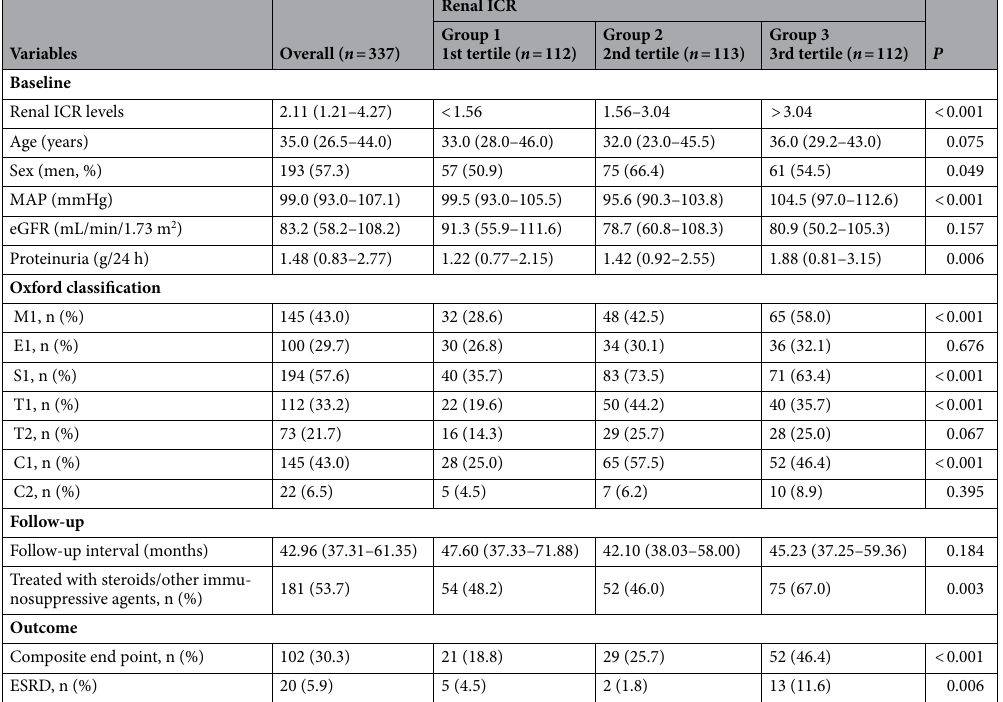
Table 1. Characteristics of IgA nephropathy patients by renal ICR tertiles at biopsy. Values were presented as number (percent) or median (25th percentile-75th percentile). Kruskal–Wallis test or chi-square test was used to compare the values among groups. The last column represents the P -values from comparisons between group 1, 2 and 3. MAP mean arterial pressure, eGFR estimated glomerular filtration rate, ESRD end stage renal